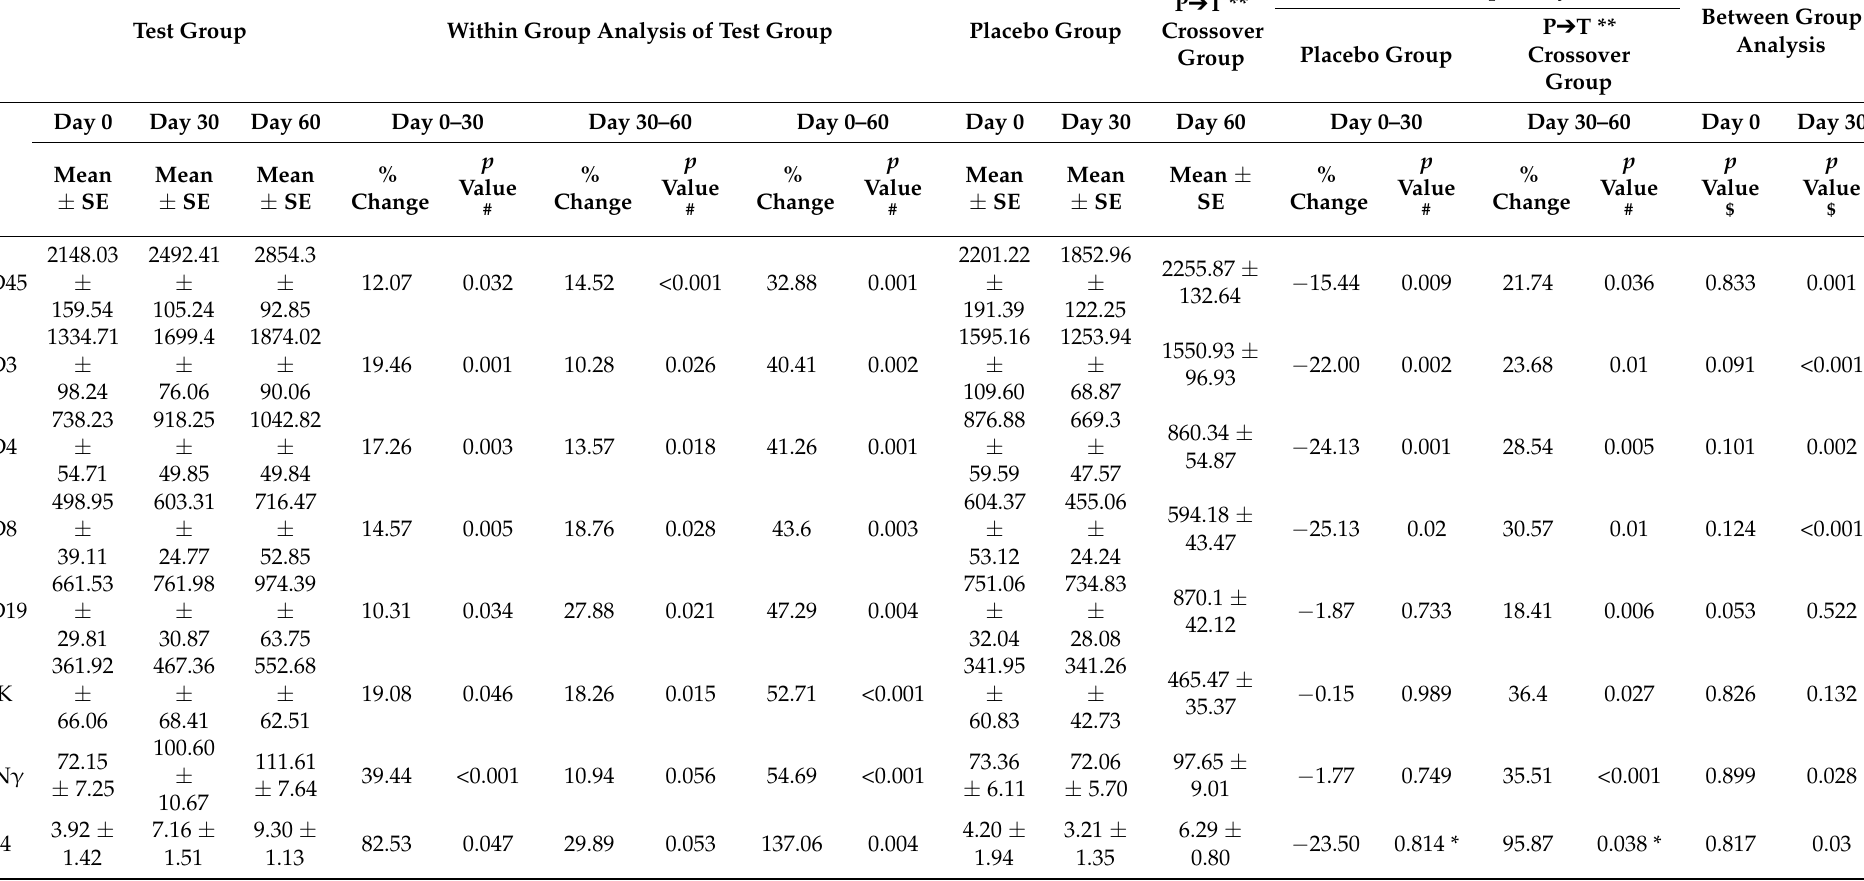
Table 3. Comparison of the level of T cells, B cells, NK cells count (cells/ µ L) in whole blood and cytokines IL4 and IFN γ level (pg/mL) in serum samples of test and placebo group at day 0, 30 and 60 using flow